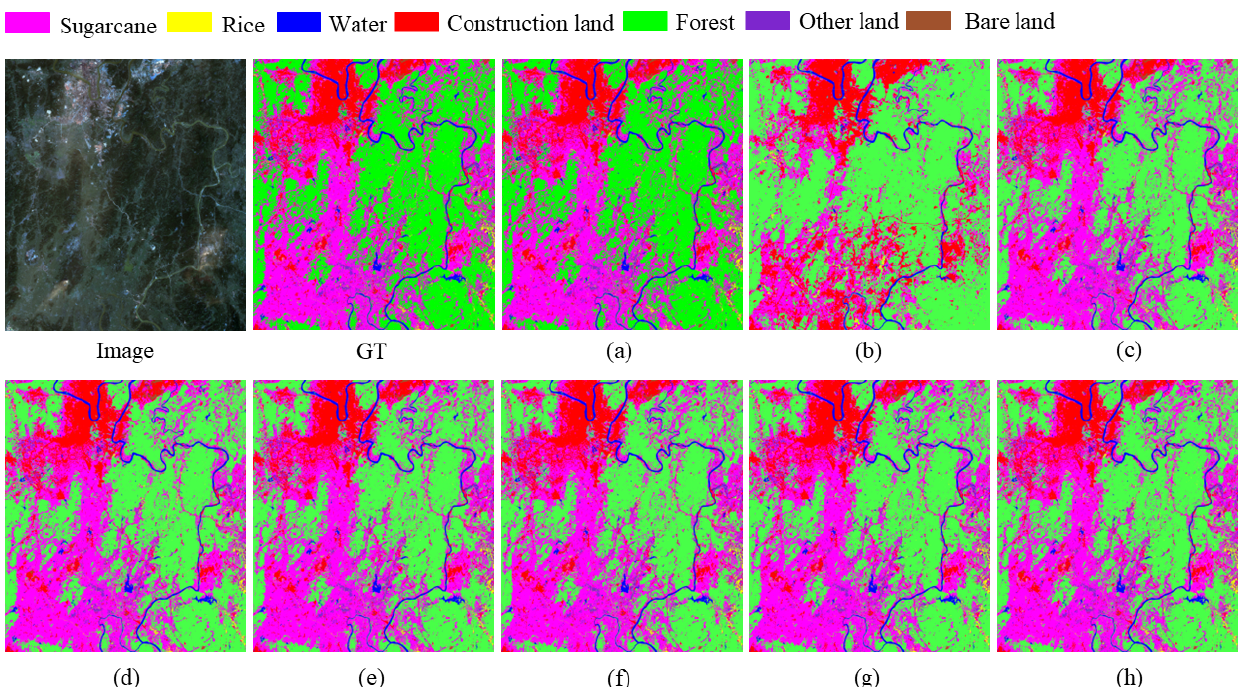
Figure 13. Semantic segmentation results on the test set in the 2021 dataset I produced by ( a ) U-Net, ( b ) U-Net++, ( c ) SAR-UNet, ( d ) Res-UNet++, ( e ) Attention-UNet, ( f ) UCTransNet, ( g ) Swin-UNet, and ( h ) SA-UNet.